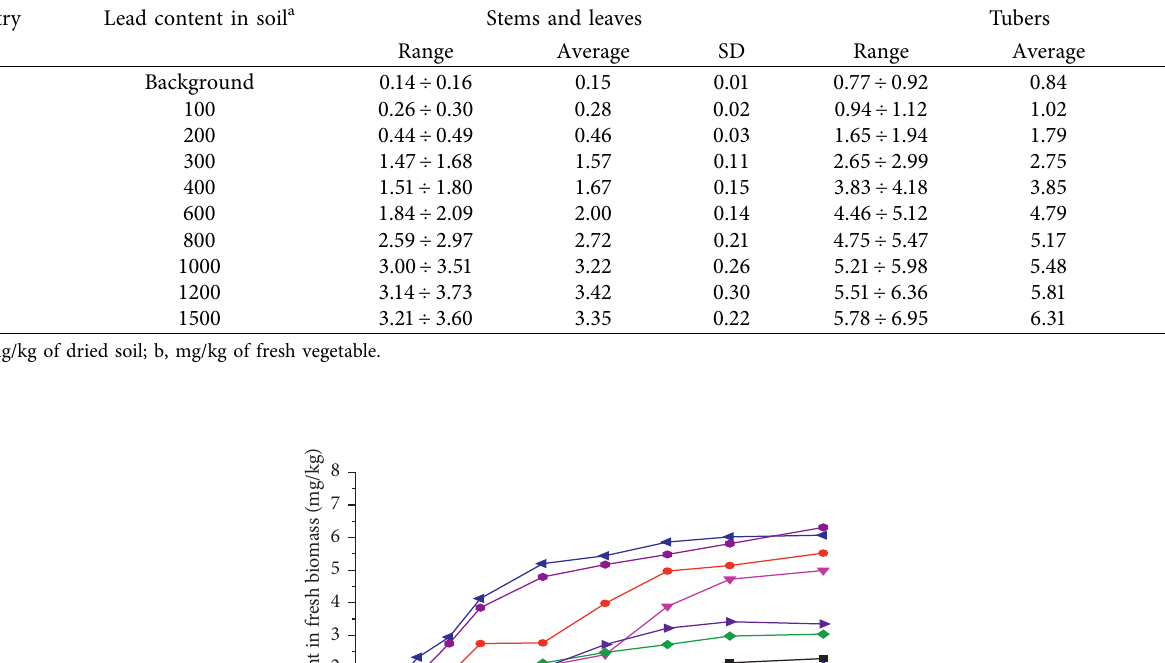
Table 6: Concentration of lead in this metal-contaminated soil and in the biomass of potato grown in this soil. Entry